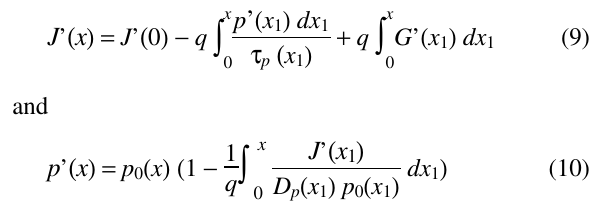
Table 1. Expressions and parameters that were used in the theoretical emitter optimization for n+